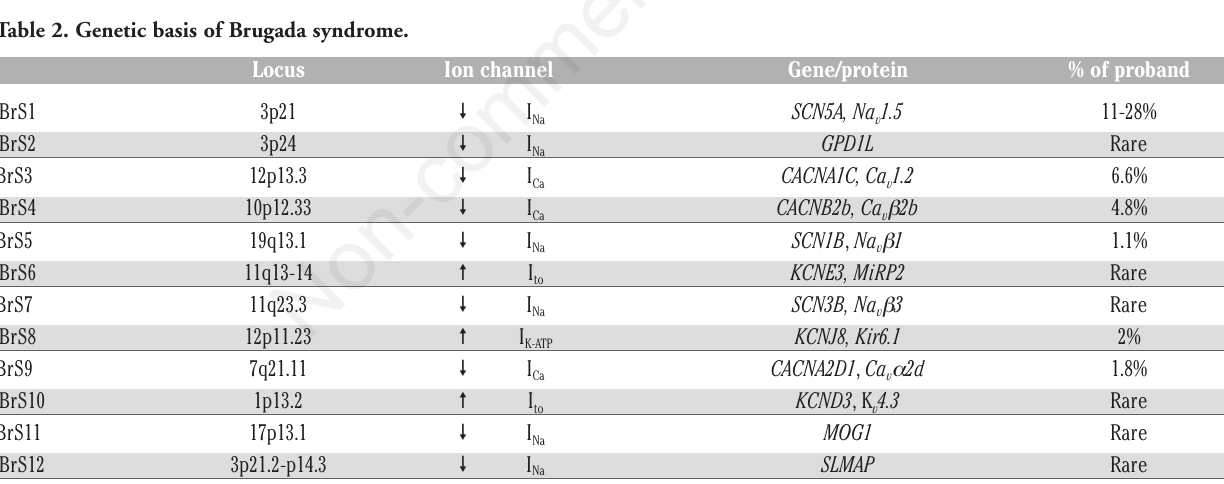
Table 2. Genetic basis of Brugada syndrome.